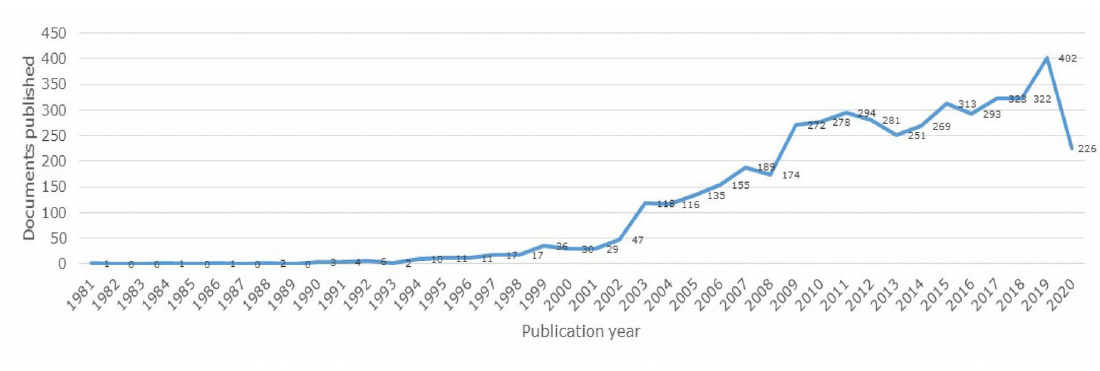
Figure 8. Annual publications in Organizational Culture from 1981 to 2020 (25 th July)